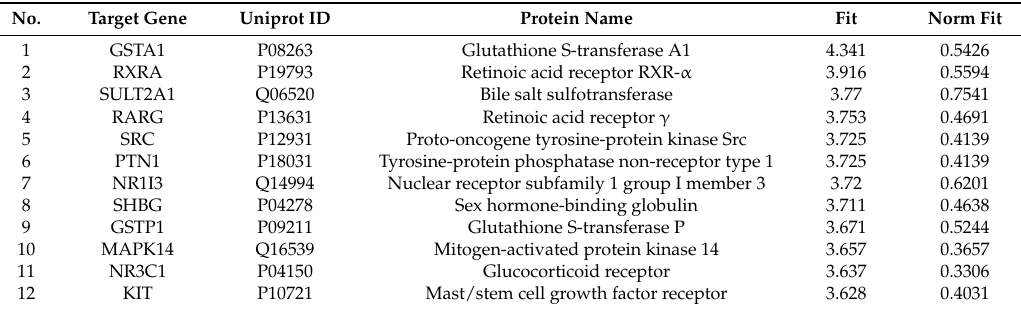
Table 1. The fitting score of docking of carainterol A with potential targets.